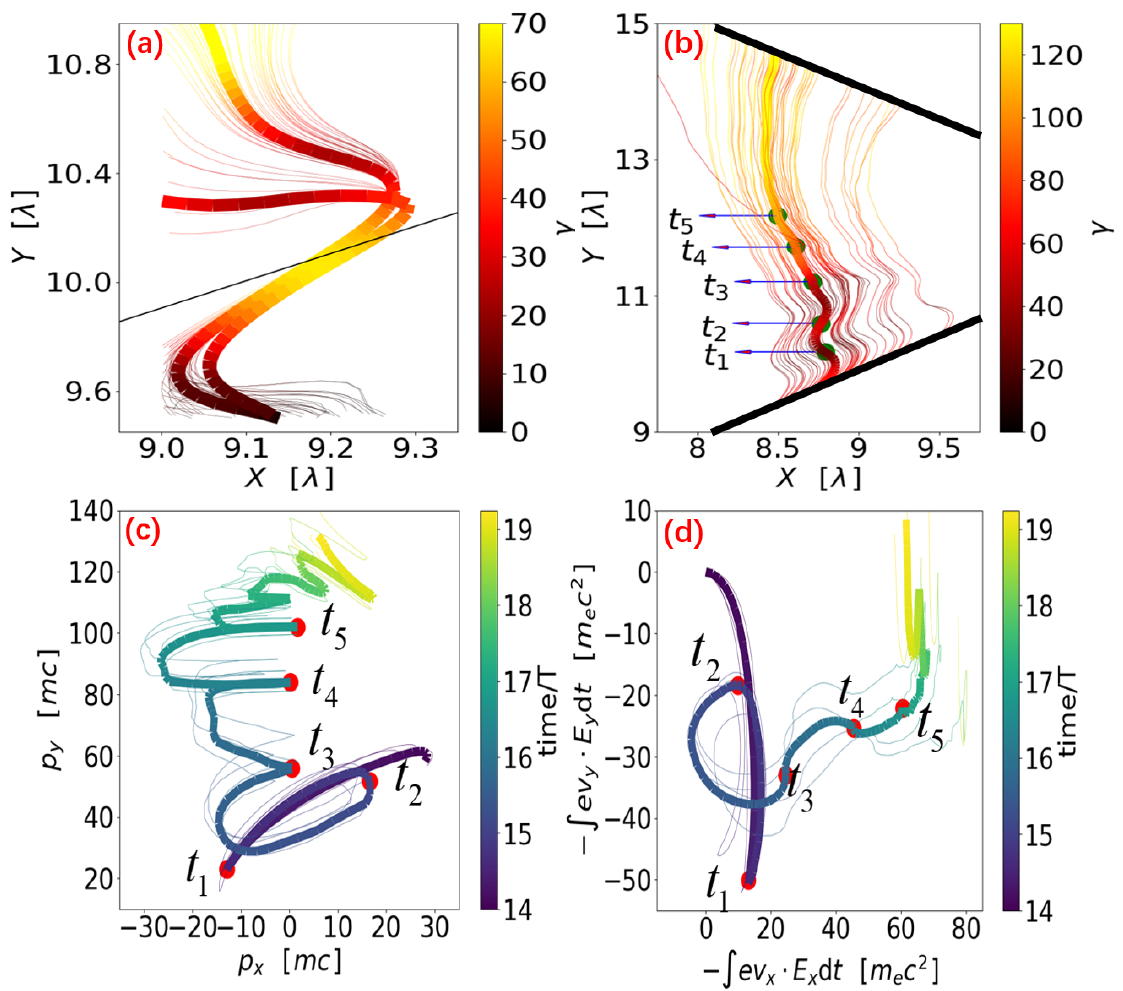
Figure 3. (Color online). ( a ) The electron trajectories during the emission of HHG. ( b ) The electron trajectories after leaving the target surface. ( c ) The variation in electron momentum p x over time. ( d ) The work carried out by the electric field on the electrons. The values of t 1 , t 2 , t 3 , t 4 and t 5 are 14.30 T 0 , 14.74 T 0 , 15.37 T 0 , 15.90 T 0 , 16.37 T 0 ,